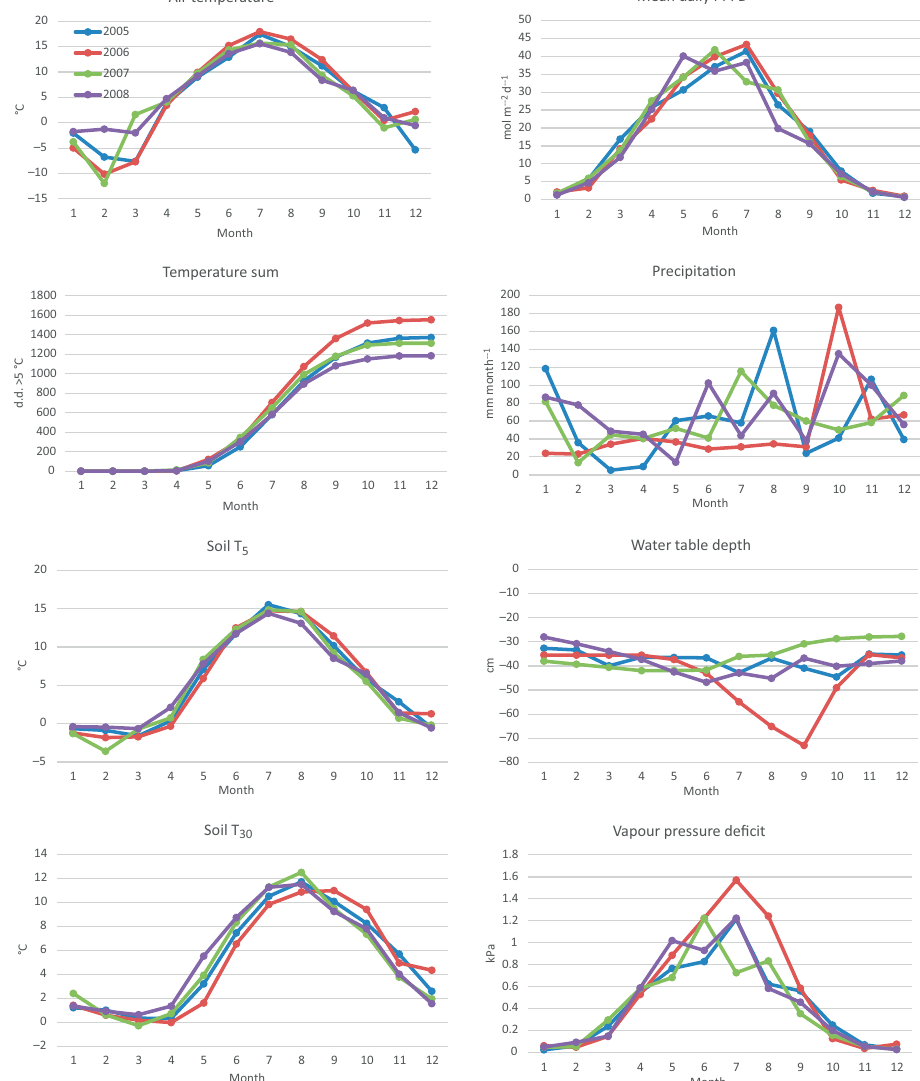
Figure 2. Weather variables by year and month, measured at Kalevansuo, except precipitation, which is an average from nearby weather stations. Mean daily air temperature ( ◦ C) and temperature sum (>5 ◦ C d.d.) at 2m height, soil temperatures ( ◦ C) at 5 and 30cm